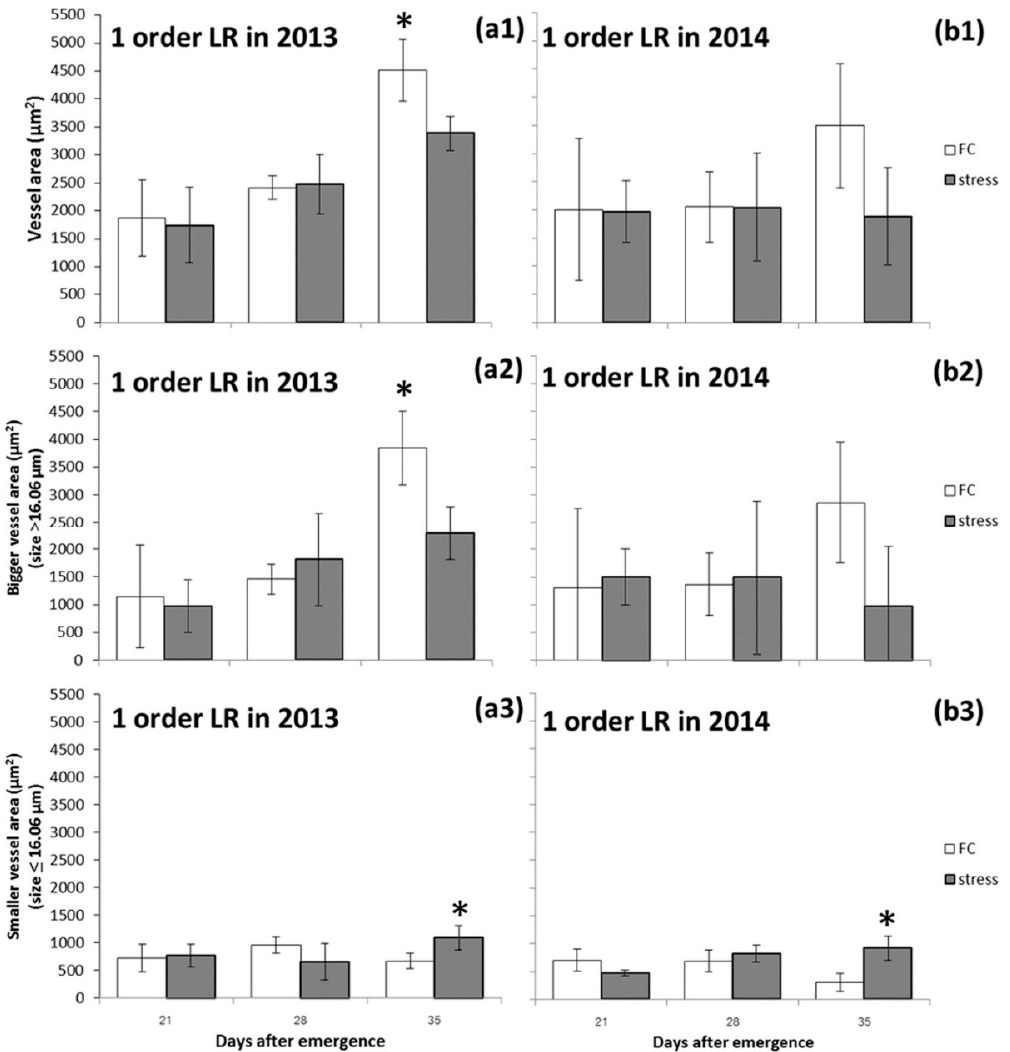
Figure 6. Vessel area ( a1 , b1 ), bigger vessel area ( a2 , b2 ) and smaller vessel area ( a3 , b3 ) of first order lateral roots of peanut at 21, 28 and 35 DAE in 2013 ( a ) and in 2014 ( b ); Significant at * p ≤ 0.05, non-stress treatments ( □ ) and stress treatments ( ■ ).